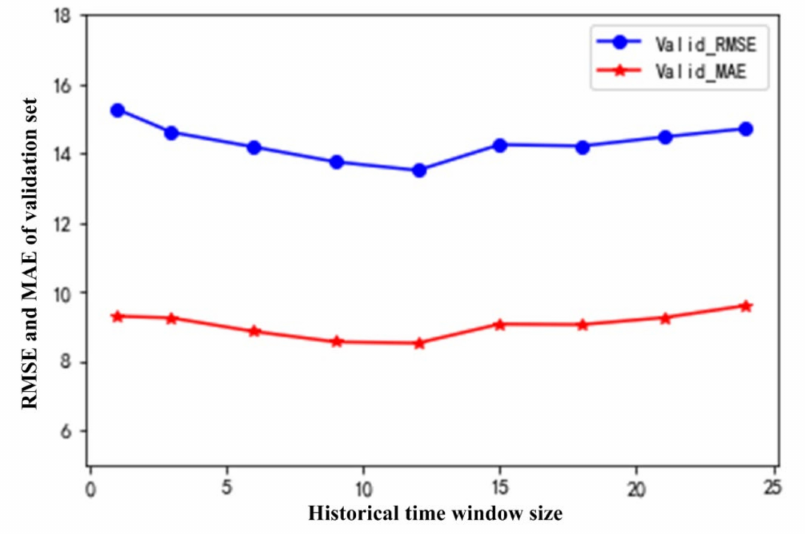
Figure 9. The RMSE and MAE of the LSTM verification set under different time